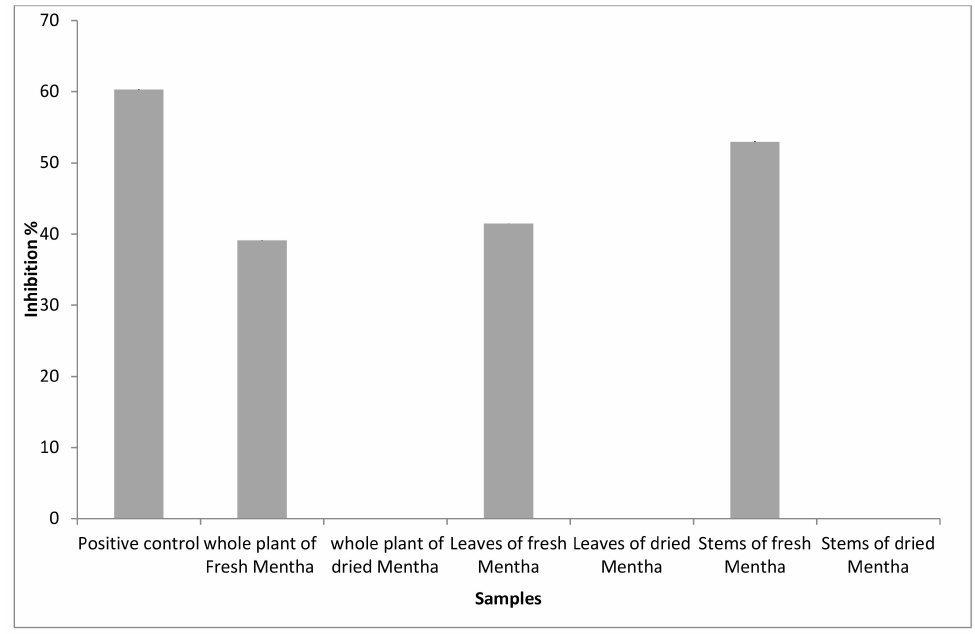
Figure 5. Antifungal activity of non-volatile constituents of M. suaveolens